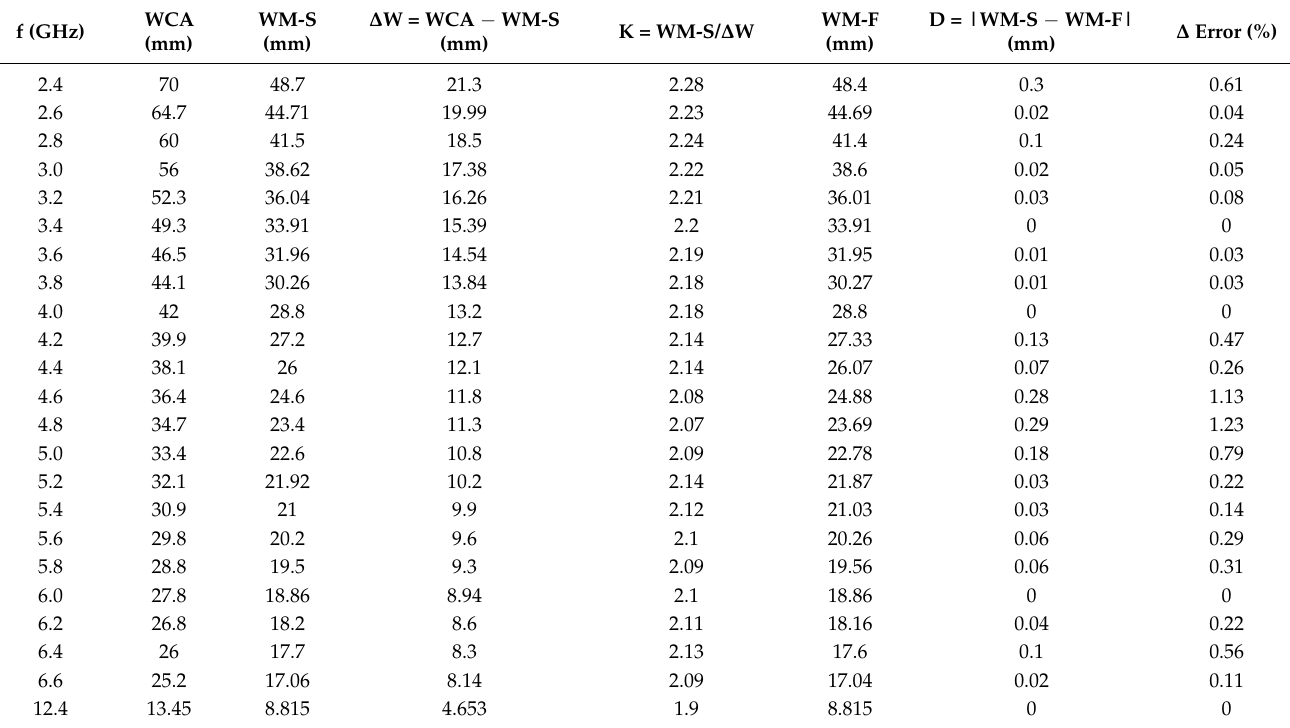
Table 3. Patch width estimation on felt substrate using CMA.